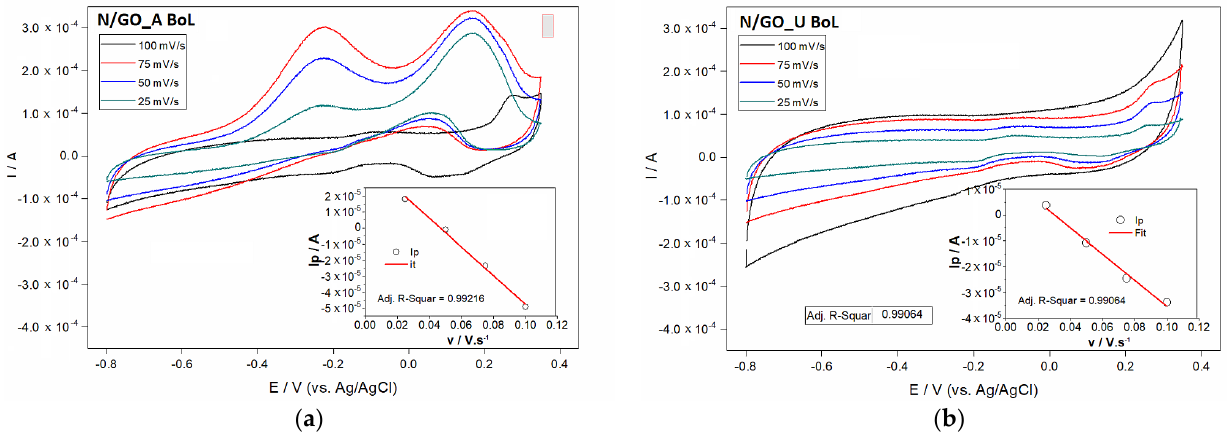
Figure 11. Cyclic voltamograms at different scan rates for N/GO_A ( a ) and N/GO_U ( b ) for BoL. Right bottom insert plot of the dependency of oxidation peak current on the square root of the rate.